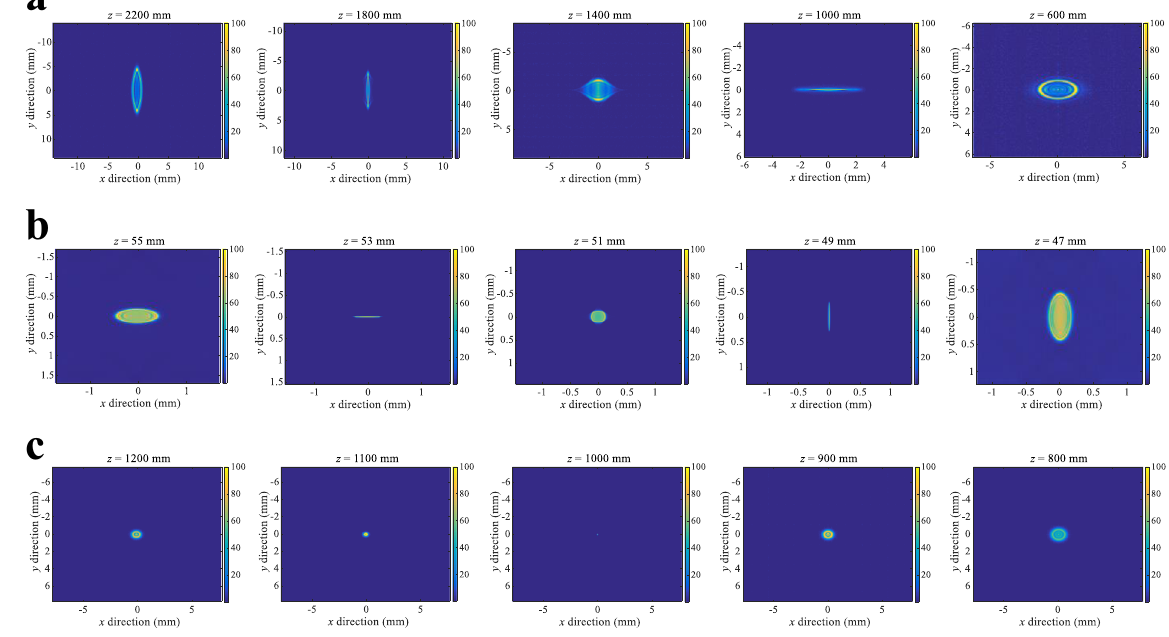
Figure 3. The aberration analysis of IMACL: ( a ) shows the PSF of the IMACL with positive anisotropic crystal when the point light source is located 55 mm behind the IMACL. ( b ) and ( c ) show the PSF of the IMACL with negative anisotropic crystal where the point light source is located 50 mm and 1000 mm behind the IMACL,